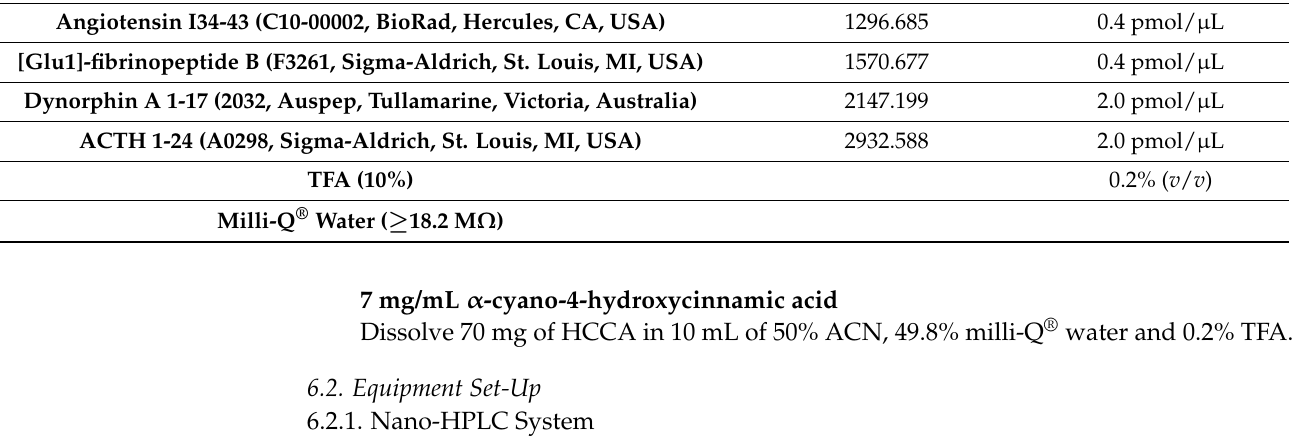
Table 1. Details of internal calibrants utilized in the set up of the MALDI UltrafleXtreme TOF/TOF. Calibrants Peptide Mass [M + H] + Final Concentration 1296.685 0.4 pmol/ µ